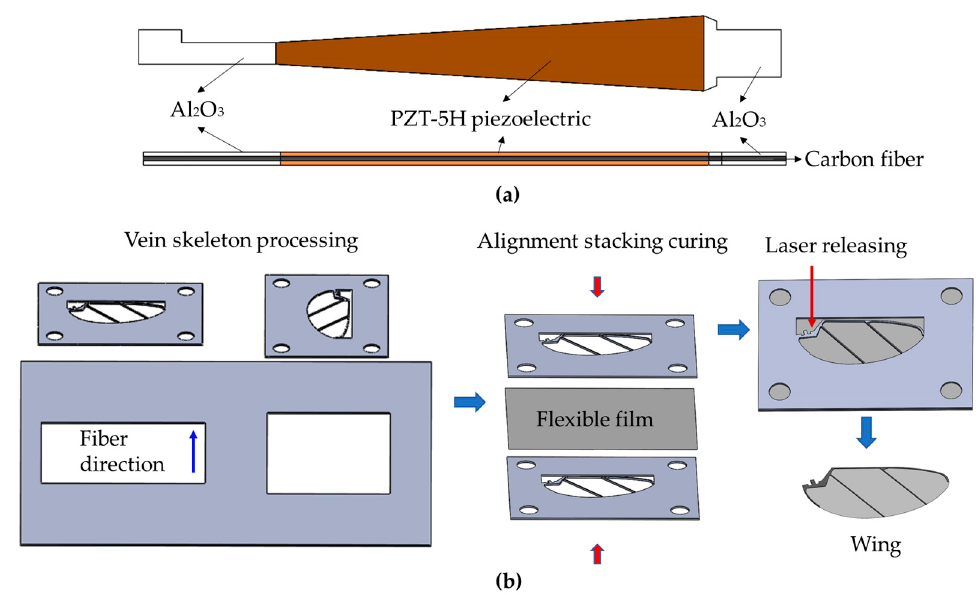
Figure 6. Actuator and wing manufacture: ( a ) specific structure of actuator; ( b ) the manufacturing process of the wings.